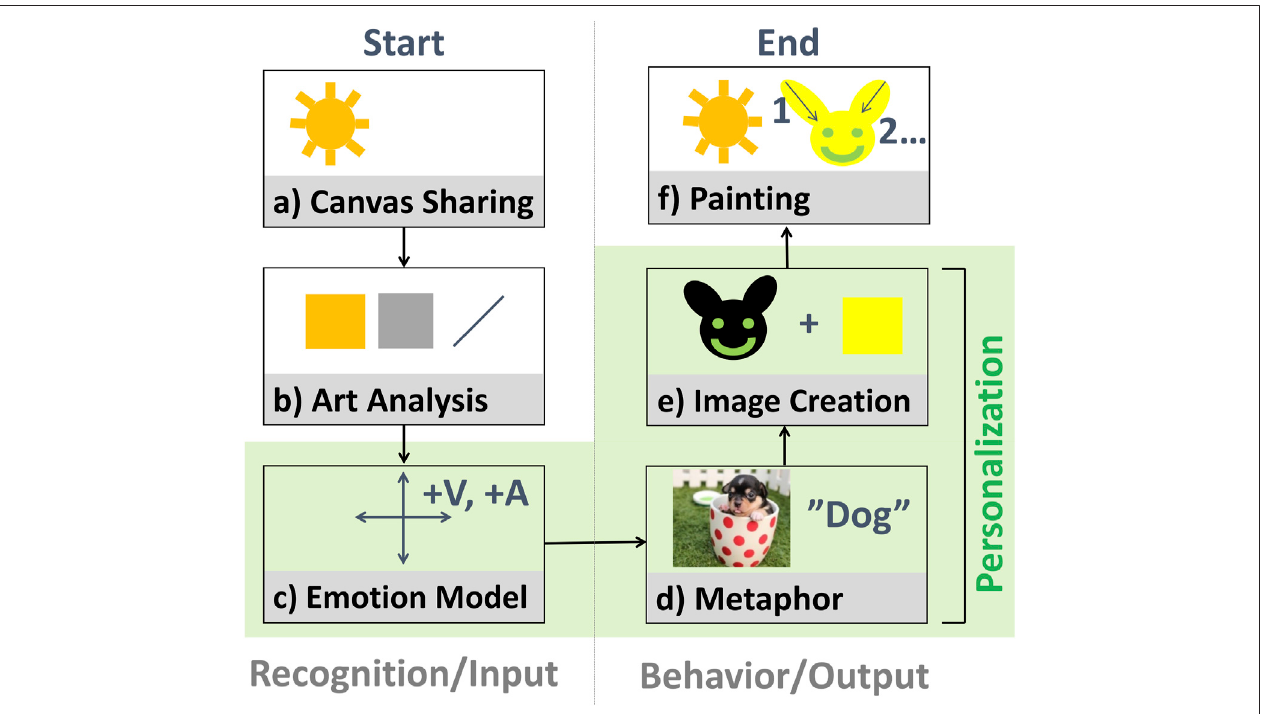
FIGURE 2 | A process fl ow for using visual metaphors to convey emotional contingency (empathy) and creativity in art that a robot creates with a human.